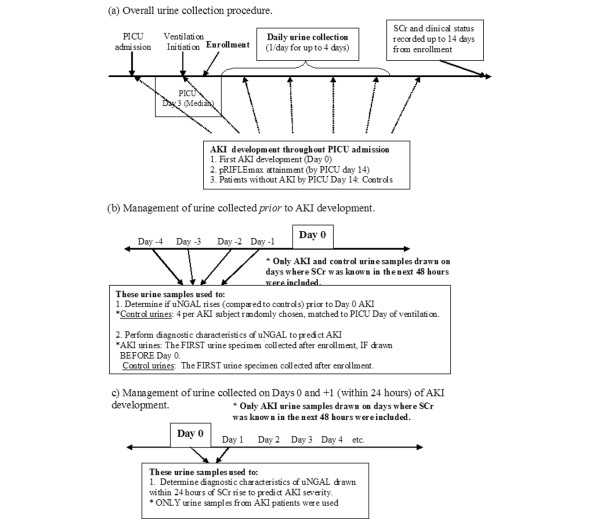
Description of urine collection procedures and use of urine specimens with reference to analytic time points. (a) Overall urine collection procedure. The image shows that study enrollment began shortly after initiation of ventilation and that urine was collected once per day for up to 4 days if possible. (b) Acute kidney injury (AKI) urine specimens collected before AKI development were used for assessment of urine neutrophil gelatinase-associated lipocalin (uNGAL) for early detection of AKI. (c) AKI urine specimens collected within 24 hours of AKI by pRIFLE (pediatric modified Risk, Injury, Failure, Loss, End Stage Kidney Disease) criteria were used to evaluate uNGAL as a marker of severity of renal injury. day 0, the first day the patient attained AKI; PICU, pediatric intensive care unit; pRIFLEmax, the worst pRIFLE stratum attained; SCr, serum creatinine; uNGAL, urine neutrophil gelatinase-associated lipocalin.